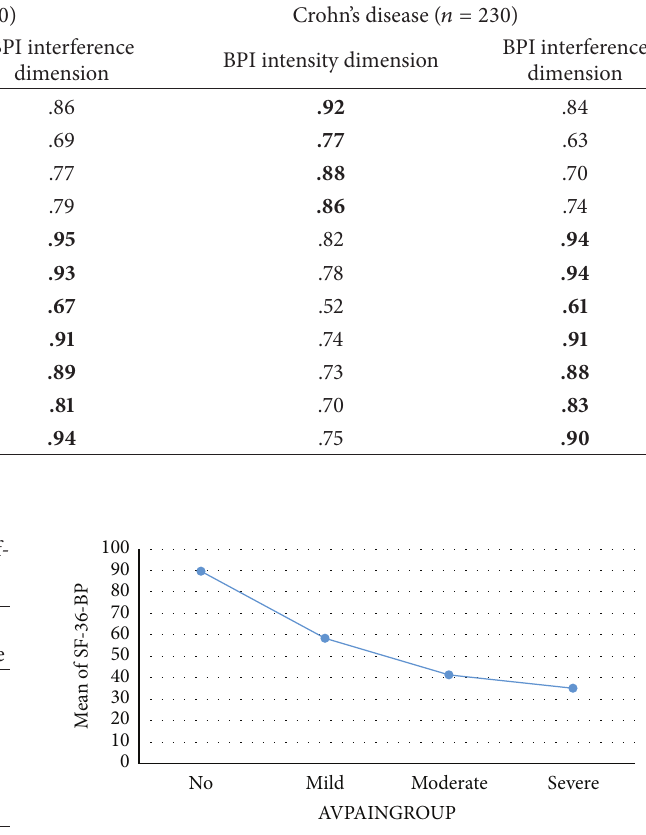
Figure 2: Mean SF-36 bodily pain (BP) in Crohn’s disease according to average pain severity. SF-36: Short-Form 36. AVPAINGROUP: average pain grouped according to cut-off values 0 = no, 1–3 mild, 4–6 moderate, and ≥ 7 severe. Mean bodily pain scored from 0 to 100. A higher score indicates less